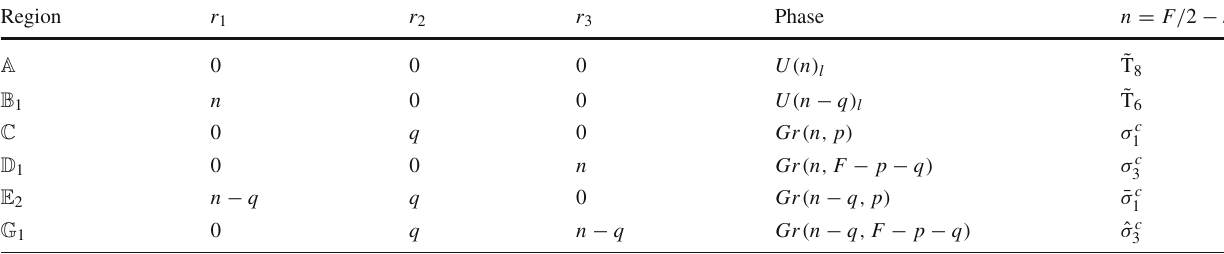
Table 4 Phases of the bosonic theory with q ≤ n < p ≤ F − p − q ≤ F Region r 1 r 2 r 3 Phase